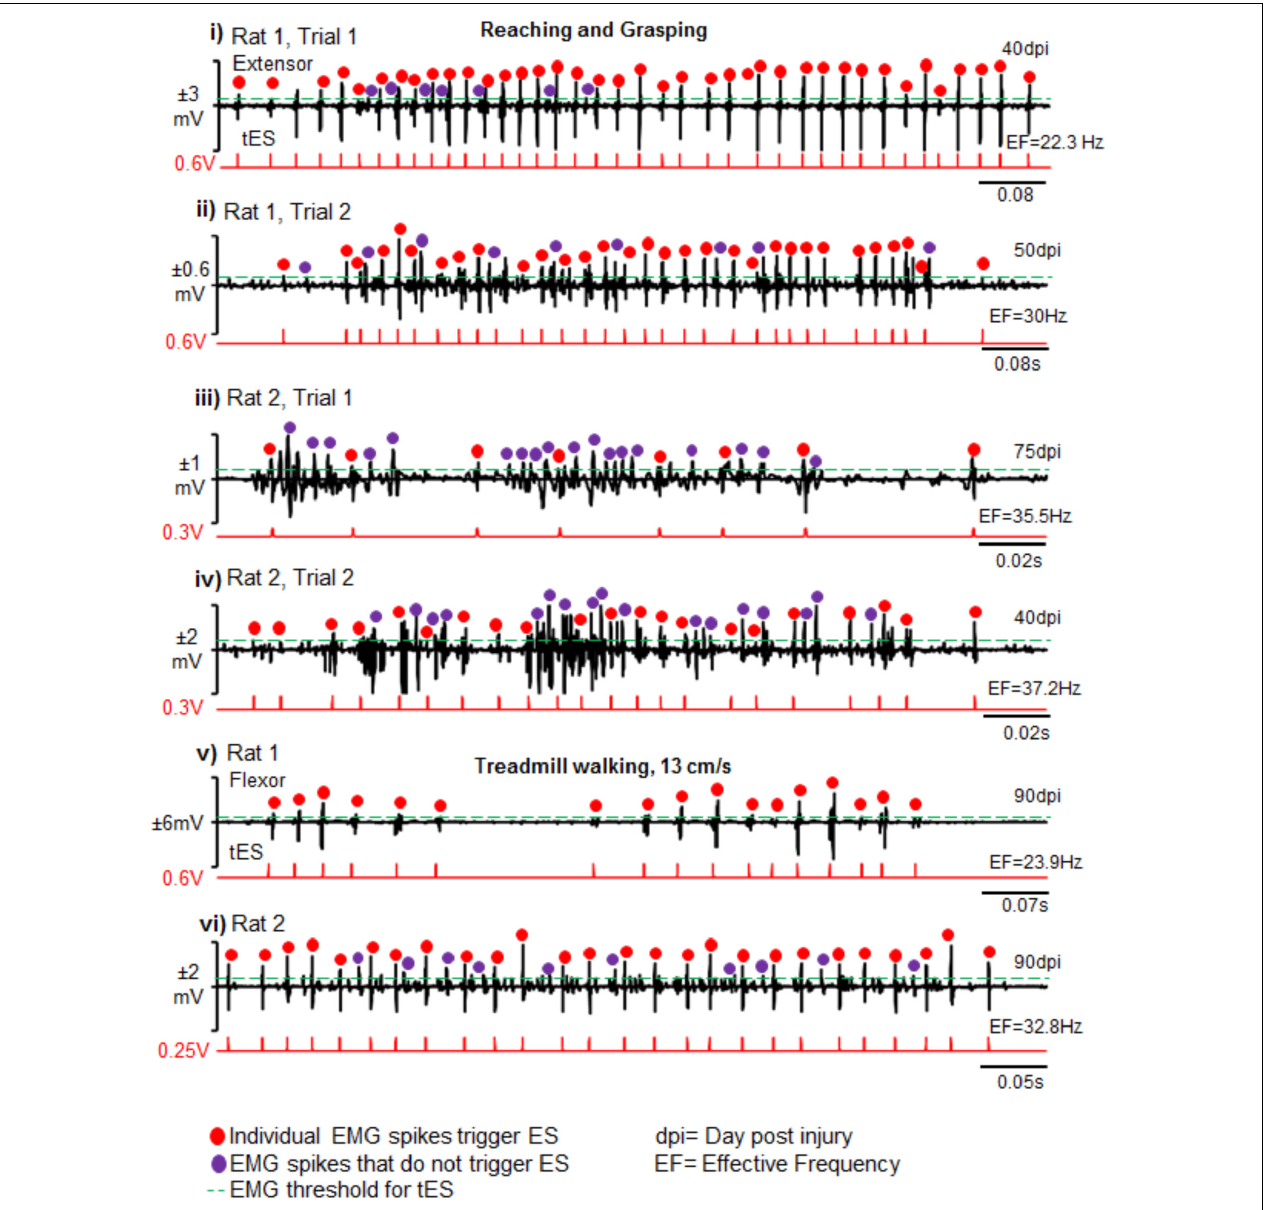
FIGURE 8 | Reliability and validity of closed-loop spinal ES system. Shown are representative EMG bursts along with corresponding tES during two trials of reaching-grasping activity for Rat 1 (i,ii) and Rat 2 (iii,iv) at different days post injury (dpi). (v,vi) Similarly, representative EMG data from a single trial are shown from two rats (Rat 1 and Rat 2) during treadmill walking at 13 cm/s. Red dots are EMG spikes that trigger tES. Violet dots are spikes that cross the user-defined threshold, but do not trigger tES because of the preset inter-stimulation interval time. As expected, the closed-loop system consistently delivered tES in response to the EMG spikes (red dots) that crossed a tester defined threshold (green line) for a multitude of motor tasks between and within rats. Note that the resultant effective frequency (EF) directly depends upon bursting activity of the